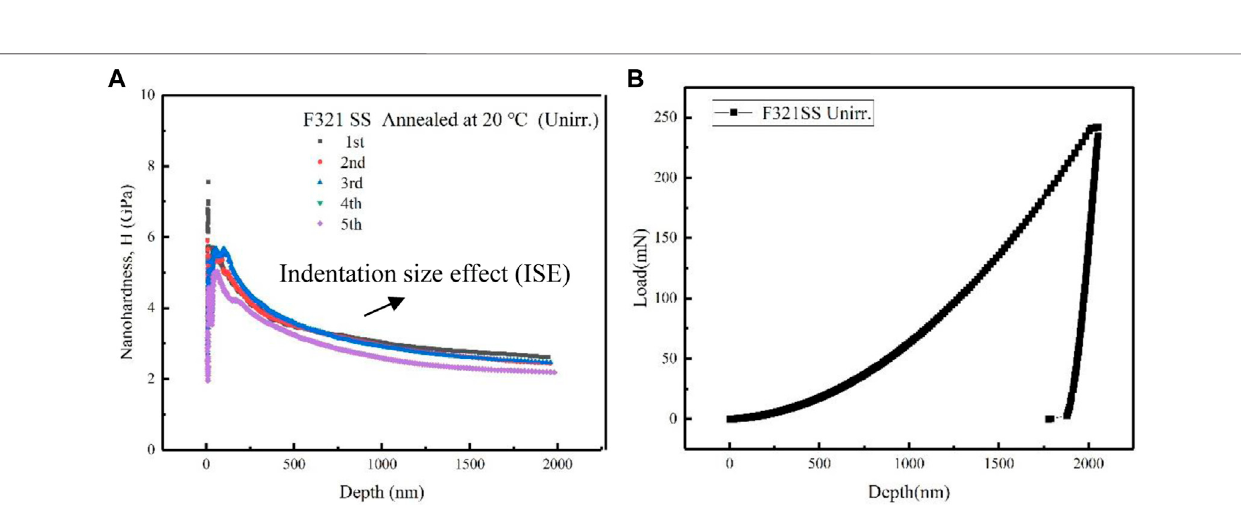
Frontiers in Materials |